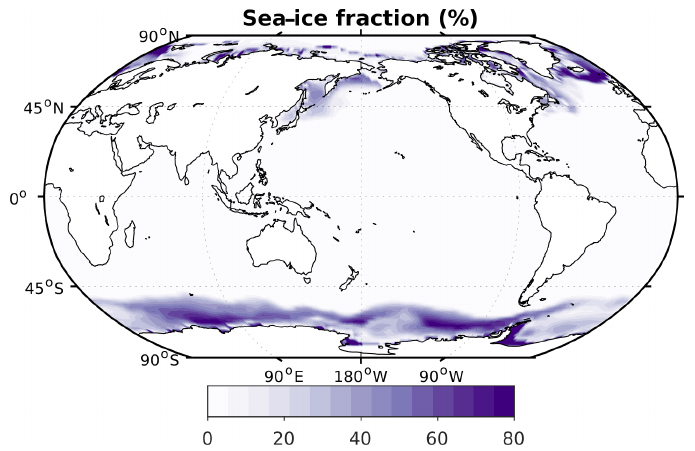
Figure A3. Annual mean model spread of sea-ice